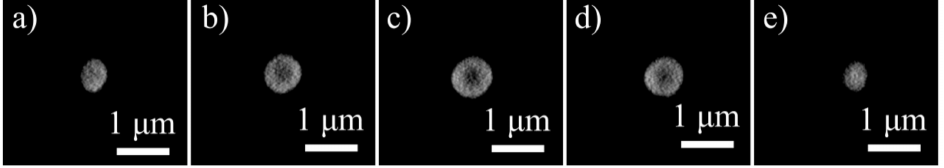
Figure 4. ( a – e ) A group of synchrotron radiation X-ray imaging technology images of spherical nanoenergetic derivatives.